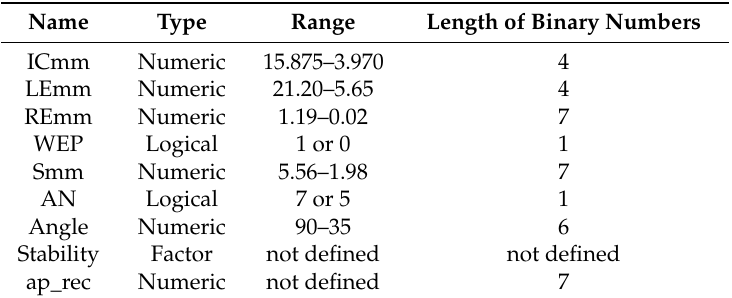
Table 6. Insert features descriptions for the decoding